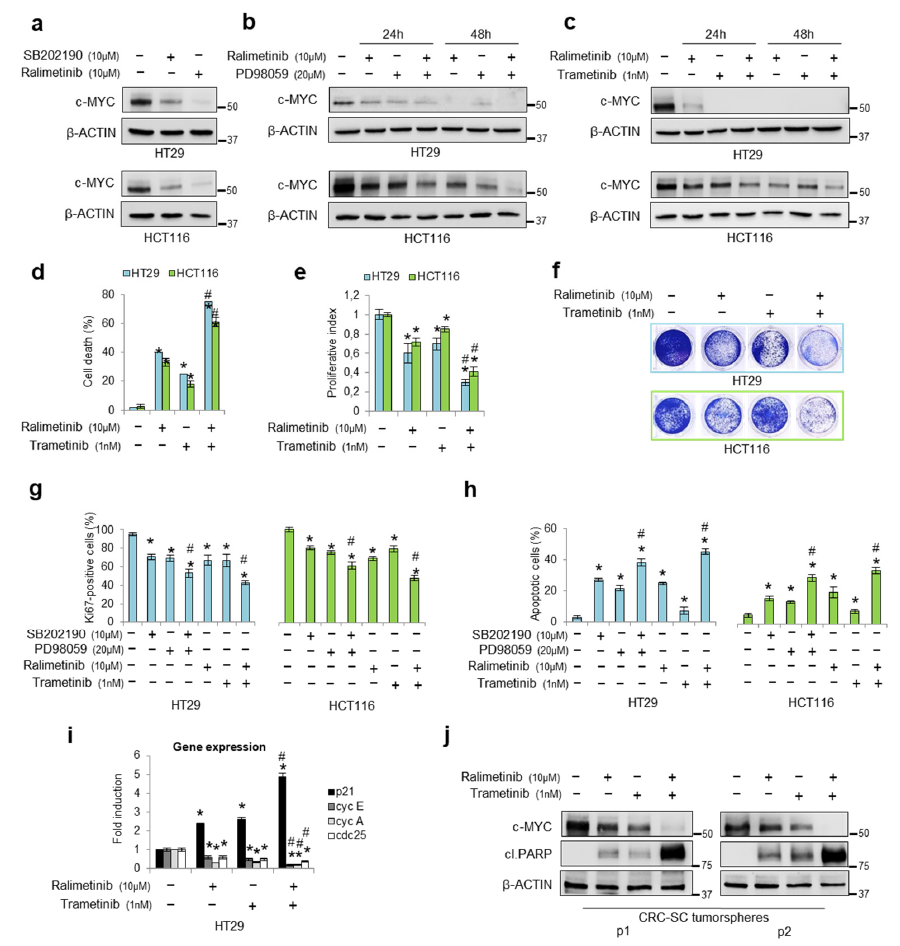
Figure 4. Pharmacological inhibition of p38 α and MEK as a synthetic lethality approach. ( a ) Im- munoblotting showing c-MYC protein levels in HT29 and HCT116 cells treated for 24 h with SB202190 (10 µM) or ralimetinib (10 µM). ( b ) Immunoblotting showing c-MYC protein levels in HT29 and HCT116 cells treated for up to 48 h with ralimetinib (10 µM) and/or PD98059 (20 µM). ( c ) Immunoblotting showing c-MYC protein levels in HT29 and HCT116 cells treated for up to 48 h with ralimetinib (10 µM) and/or trametinib (1 nM). ( d ) Quantification of cell death by trypan blue staining in HT29 and HCT116 cells treated with ralimetinib (10 µ M) and/or trametinib (1 nM) for 48 h.